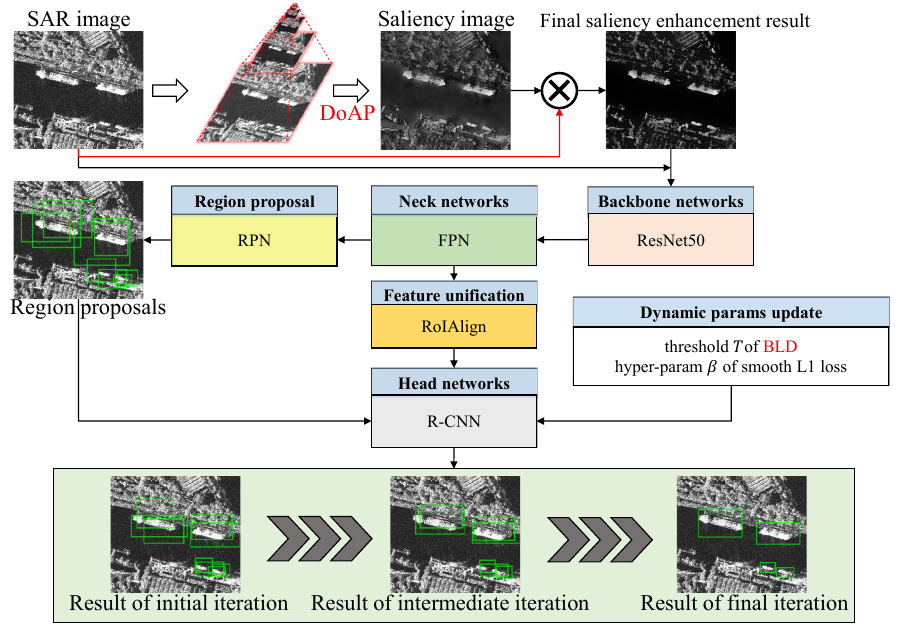
Figure 3. Overall architecture of the proposed method.